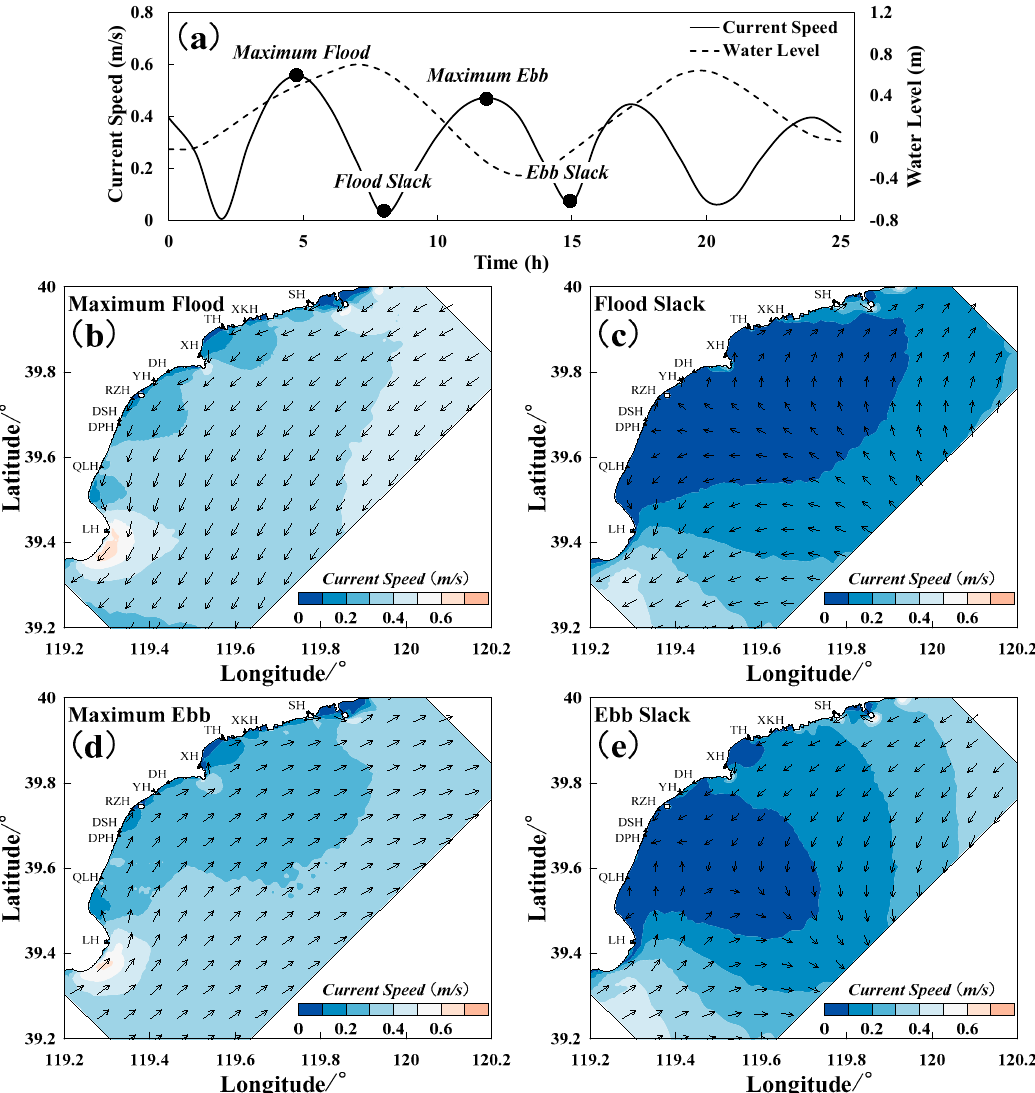
Figure 6. ( a ) The variations of water level and current speed in a tidal cycle; the flow fields of ( b ) maximum flood, ( c ) flood slack, ( d ) maximum ebb, and ( e ) ebb slack. Abbreviations: Luanhe River (LH), Qilihai Lagoon (QLH), Dapuhe River (DPH), Dongshahe River (DSH), Renzaohe River (RZH), Yanghe River (YH), Daihe River (DH), Xinhe River (XH), Tanghe River (TH), Xinkaihe River (XKH), and Shihe River (SH).